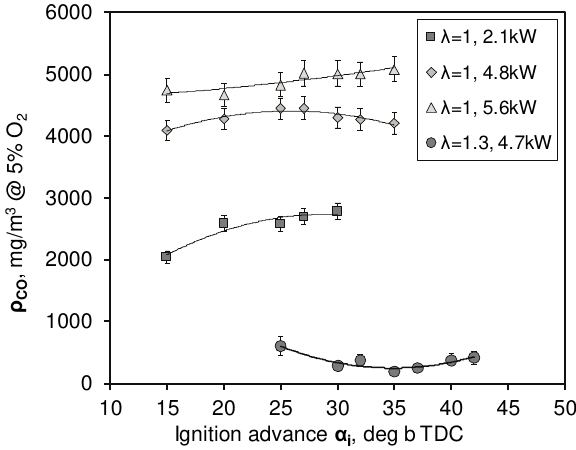
Fig. 5. CO concentration adjusted to 5% of O 2 in dry exhaust vs ignition timing, throttle position and mixture